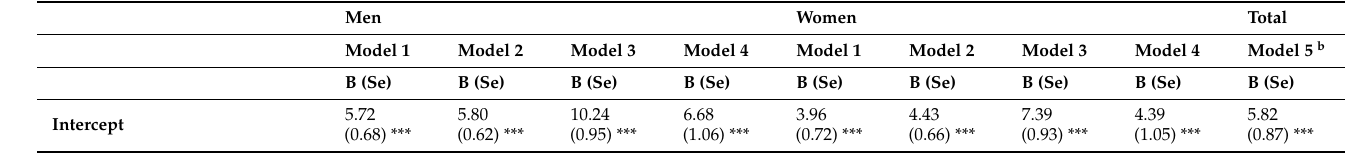
Table 6. Multilevel models a for the associations between SW and values in NEET men (n = 2100) and women (n =